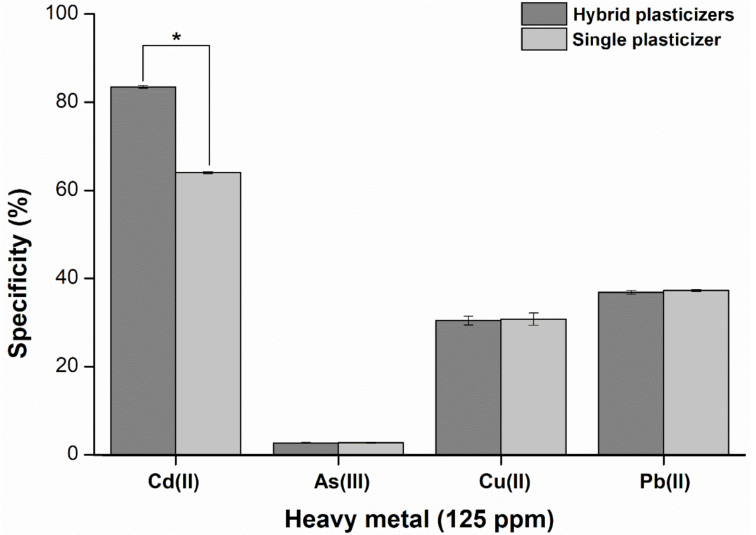
Figure 12. Specificity comparison between the single (DOS) and hybrid (DOS:TOTM) plasticizer sensors composed of TBACl as an ion exchanger ( n = 5), (* p -value <